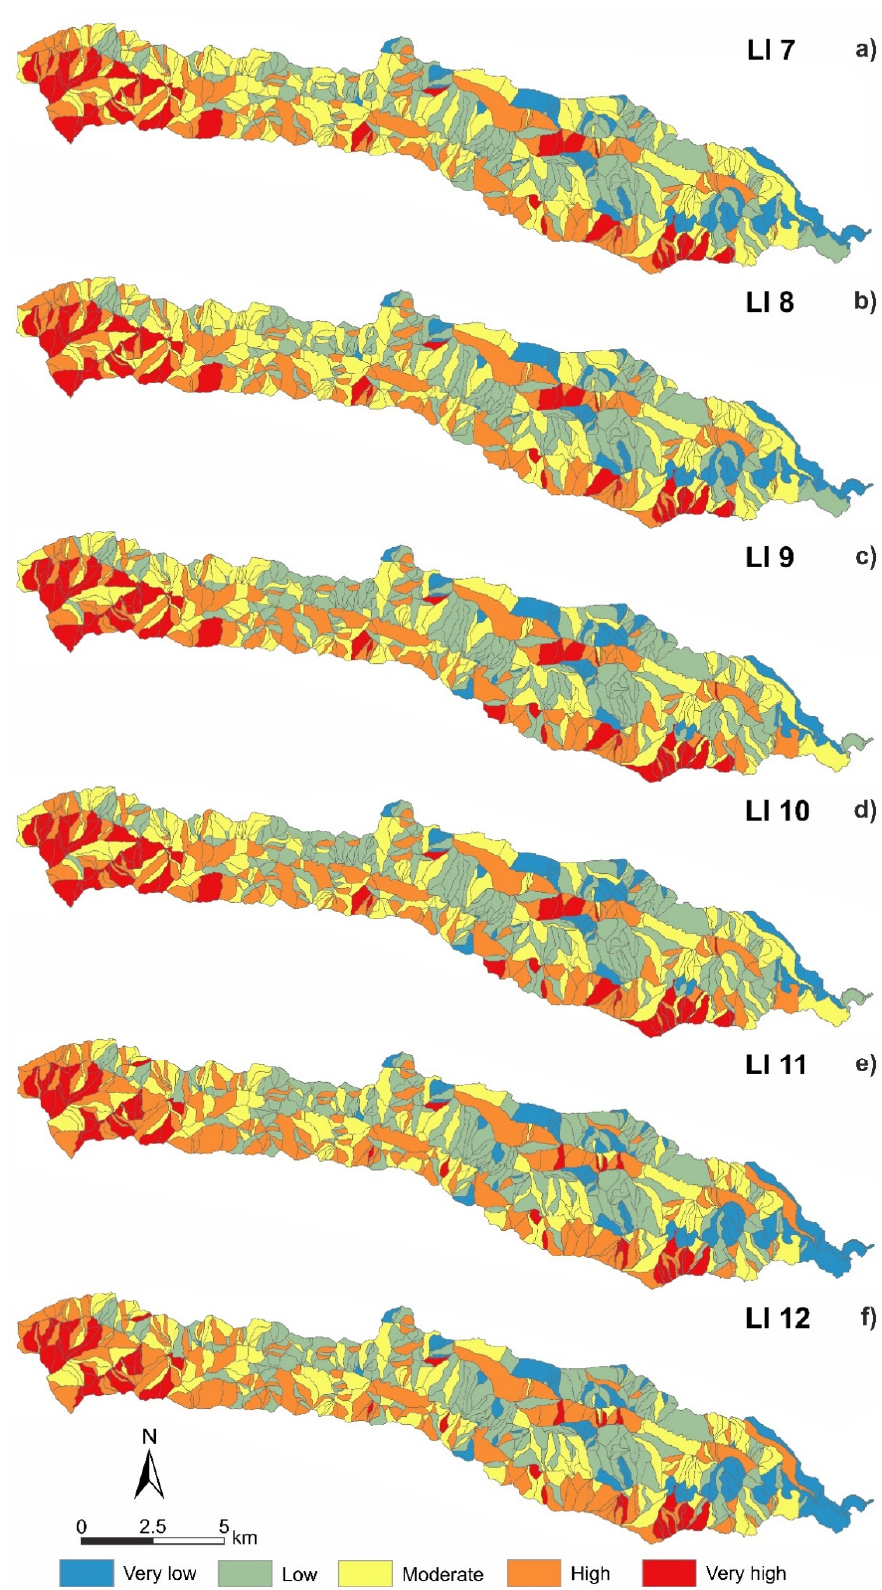
Figure 10. Landslide susceptibility maps created with the LI method: ( a ) LI_7 model; ( b ) LI_8 model; ( c ) LI_9 model; ( d ) LI_10 model; ( e ) LI_11 model; ( f ) LI_12 model.